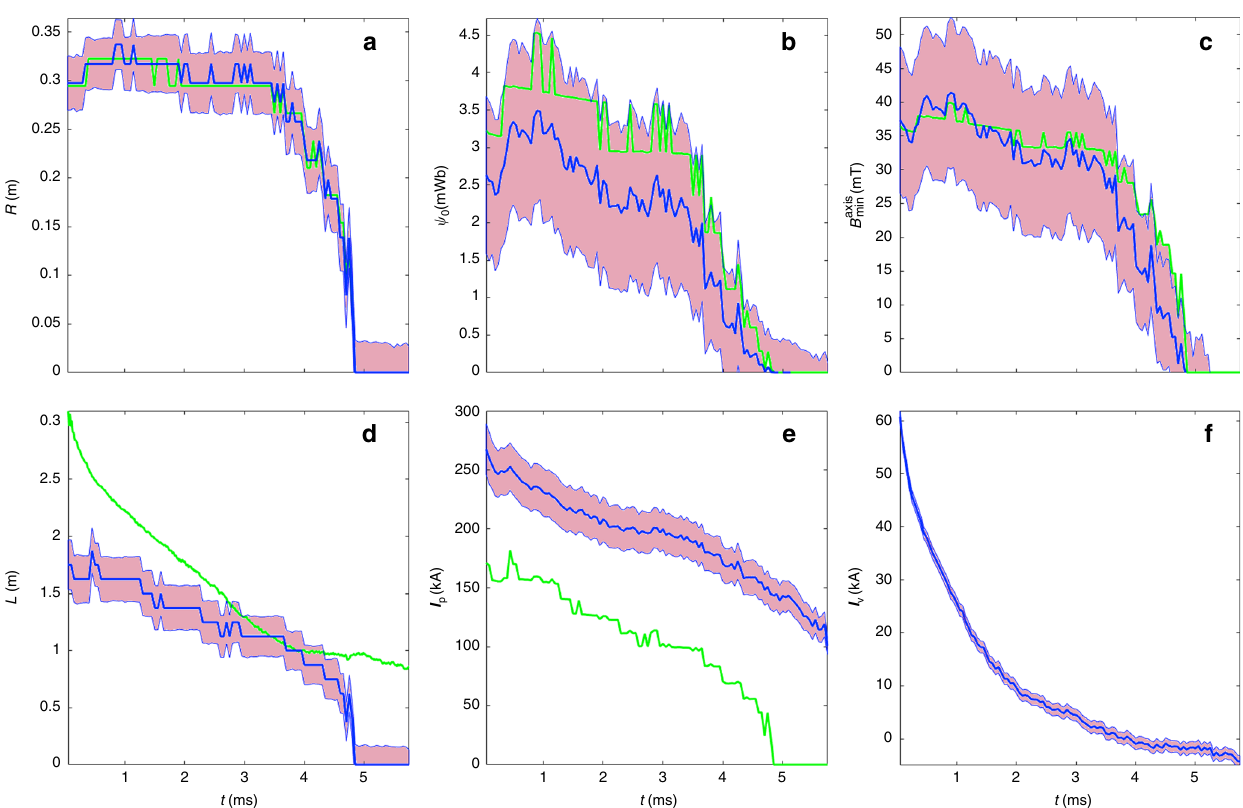
Fig. 7 Inference of plasma magnetic related variables. Solid lines correspond with mean values of the posterior distribution, and shaded areas are a measure of the uncertainty of the inferred variables corresponding to one standard deviation for shot # 48269. a Separatrix radius R s (blue) and o-point radius R 0 ffiffiffi p times 2 (green). b Trapped fl ux (blue) and the trapped fl ux approximation for a long FRC (green). c Machine axis Bz at the o-point z position (blue) and comparison with the long FRC approximation (green). d Separatrix length (blue) compared with the approximation from excluded fl ux (green). e Total plasma current (blue) and comparison with the long FRC approximation (green). f Total vessel